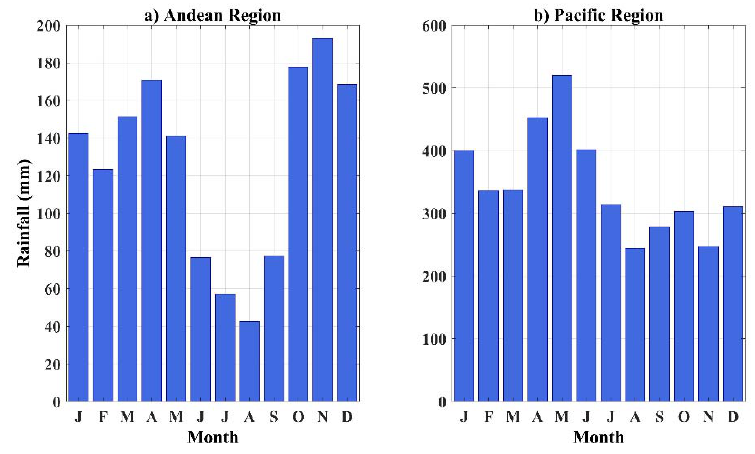
Figure 2. Multi-year monthly average. ( a ) Andean Region and ( b ) Pacific Region .